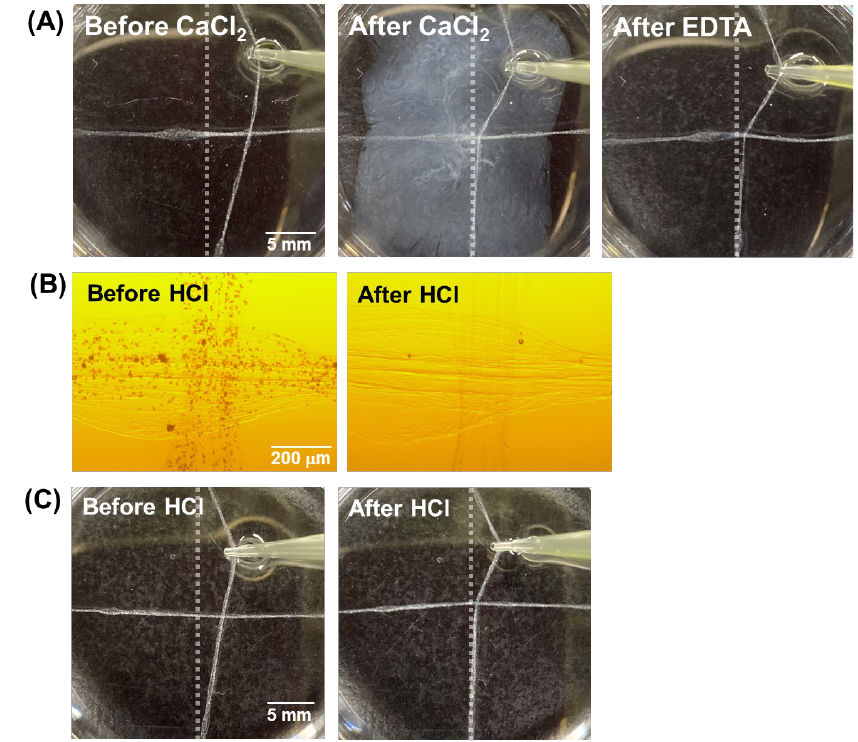
Figure 3. Binding of hydrogel fibers using CaCl 2 or HCl solution. Two fibers were arranged orthogonally, and one of the fibers was dragged away from the other: ( A ) photographs of hydrogel fibers without CaCO 3 particles before and after treatment with the CaCl 2 solution; ( B ) microphotographs and ( C ) photographs of hydrogel fibers with CaCO 3 particles before and after treatment with the HCl solution. Gray lines indicate the position of the fiber before dragging.